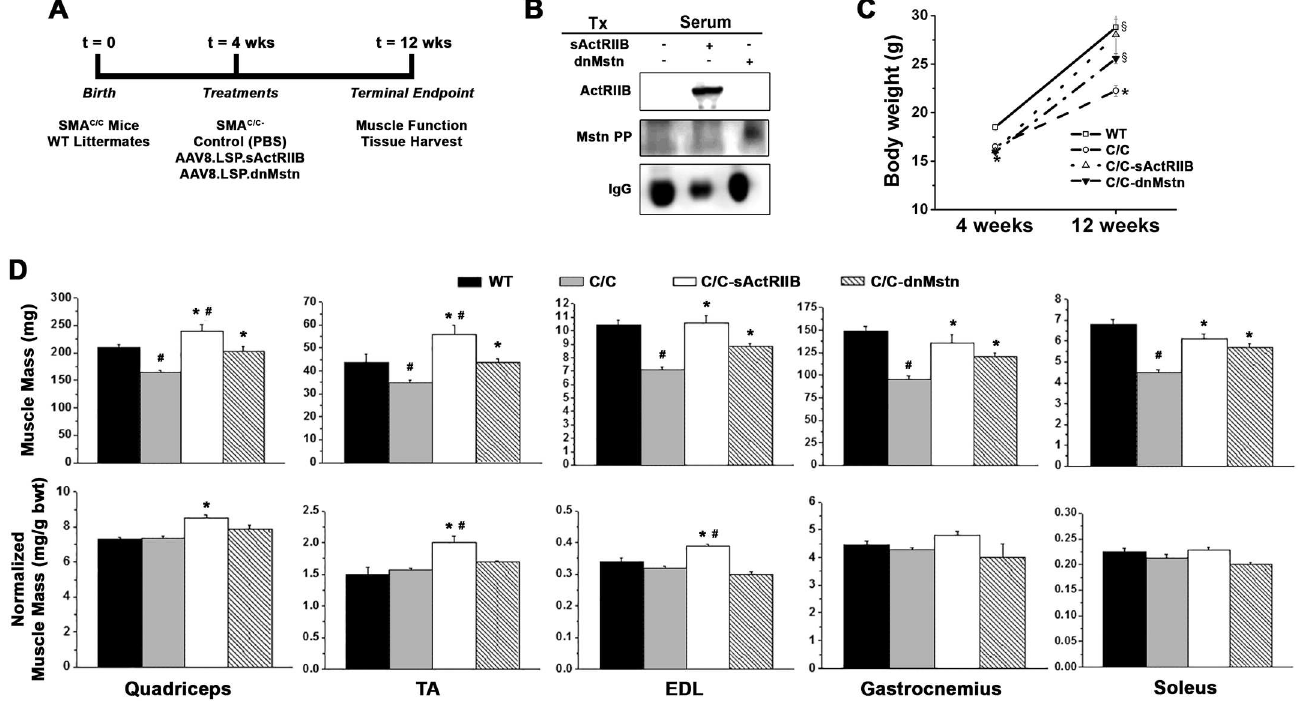
Fig 2. Activin signaling inhibition rescuesmuscle massdeficits in SMA C/C mice. ( A ) Study design of the activin inhibitionstudy, where 4 week- old SMA c/c mice receivedcontrol (PBS; n = 6), AAV8.LSP.sActRIIB (n = 6), or AAV8.LSP.dnMstn treatments (n = 6), and were evaluatedin comparisonto wild-type(WT; n = 6) littermates at 12 weeks of age. ( B ) Detection of systemic solubleActRIIB (sActRIIB) or dominant-negative myostatin pro-peptide (dnMstn) in the serum of treated SMA c/c using antibodiesagainstActRIIB and Mstn N-terminus (Mstn PP). Endogenousmouse IgG serves as a loadingcontrol. ( C ) Mouse body weights at 4 weeks and 12 weeks of age, displayedas mean ± SEM and analyzedusing one-way ANOVA (Bonferroni-Dunnpost-hoc tests; * p < 0.05 vs. WT values; §p < 0.05 vs. control C/C values). ( D ) Muscle masses of quadriceps,tibialisanterior (TA), extensor digitorumlongus (EDL), gastrocnemius, and soleus muscles displayedas both absolutemass (top) and normalized to bodyweight (bottom) of WT and SMA C/C treatments group mice at 12 weeks of age. Data are displayedas mean ± SEM and analyzedusing one-wayANOVA (Bonferroni-Dunn post-hoc tests; # p < 0.05 vs. WT values; * p < 0.05 vs. control C/C values).